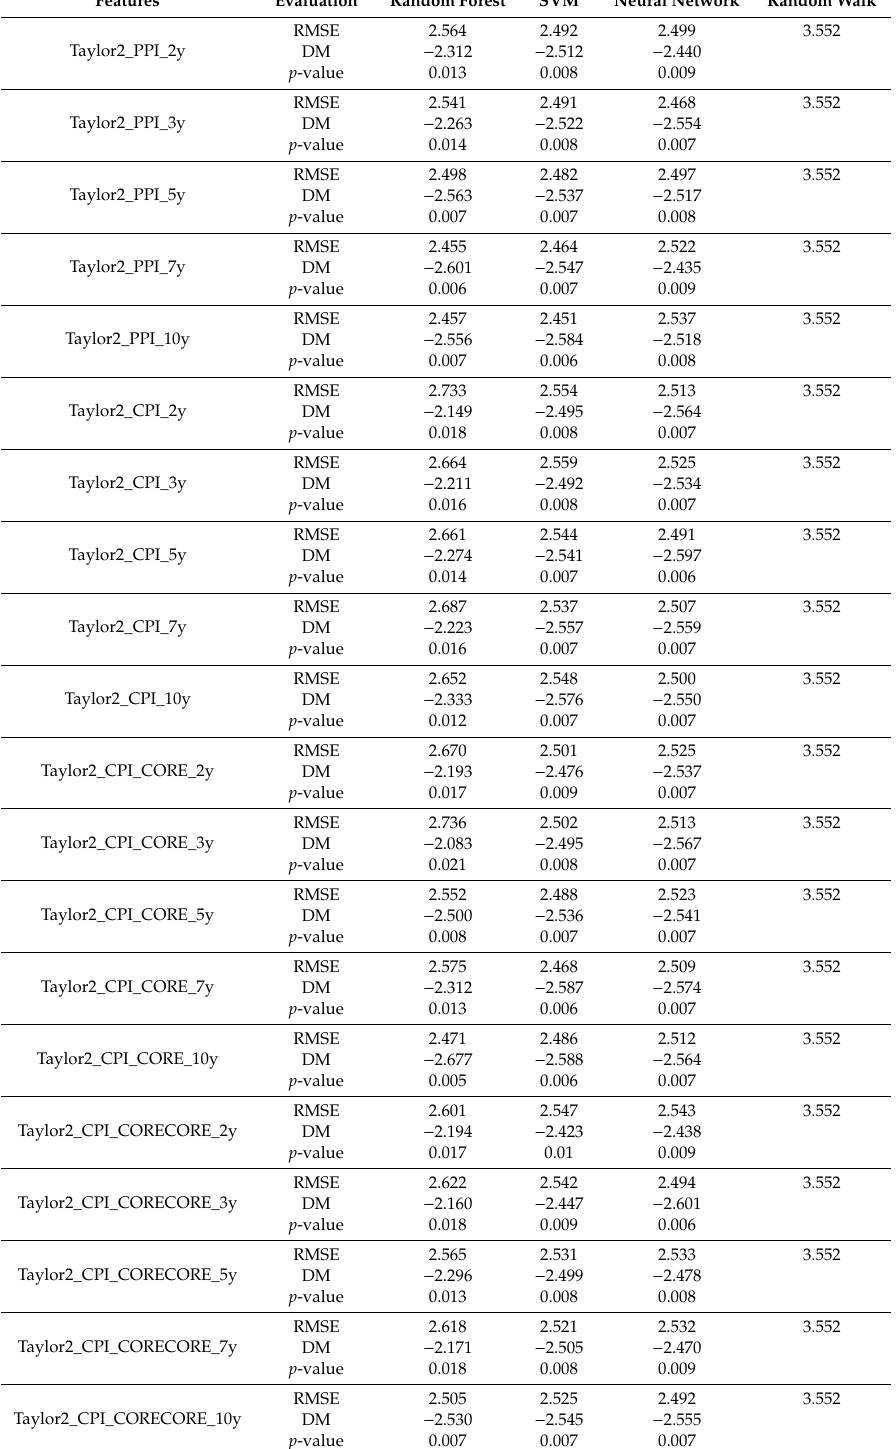
Table 6. Result for the Taylor model (Equation